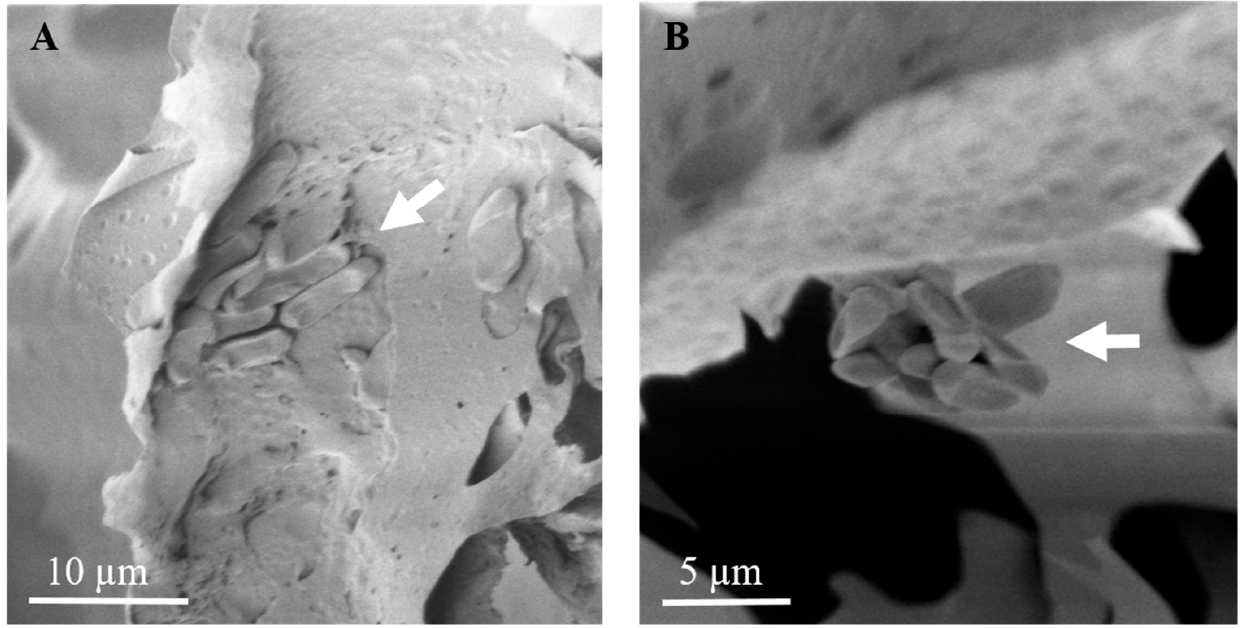
Figure 3. Scanning electron micrograph of treated foam pieces with ( A ) Mb7-GFP conidia powder 5 × 10 8 total conidia and ( B ) conidia suspension 10 8 conidia mL − 1 , within laying holes at section C. Scale bar designated in each micrograph. Arrows indicate conidia clumps in each treatment.